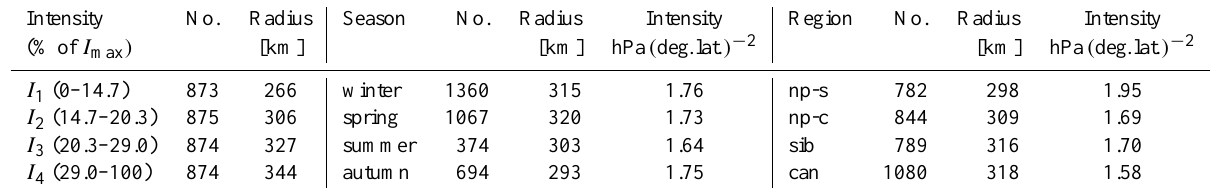
Table 2. Number of cyclone detections with corresponding mean radius and intensity for intensity quartiles, seasons, and regions. Intensity No. Radius Season No. Radius Intensity Region No. Radius Intensity (% of I max ) [km] [km] hPa ( deg . lat .) − 2 [km] hPa ( deg . lat .) −